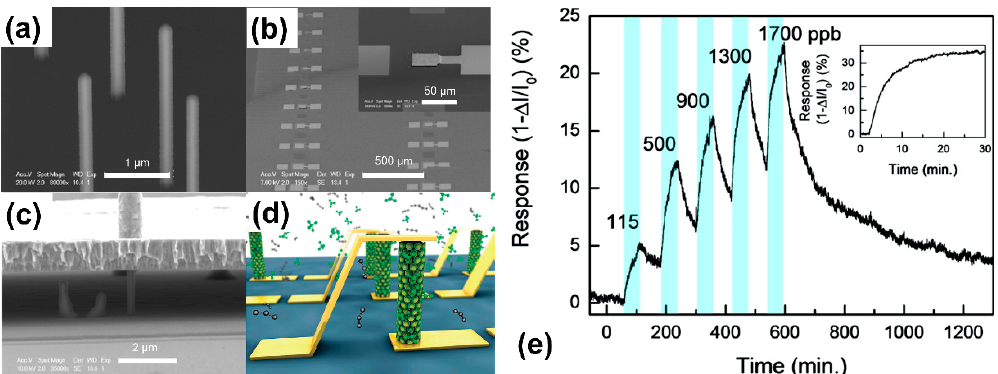
Figure 14. The fabrication process of the individual vertical nanowire device: ( a ) as-grown nanowires; ( b ) patterned nanowire arrays with air bridging contact; ( c ) a side view of an air bridge contact; ( d ) schematic image of the individual nanowire with a vertical structure; ( e ) the gas sensing performance of vertical aligned indium arsenide (InAs) nanowires sensor. Reprinted from reference [223] with permission from the American Chemical Society.